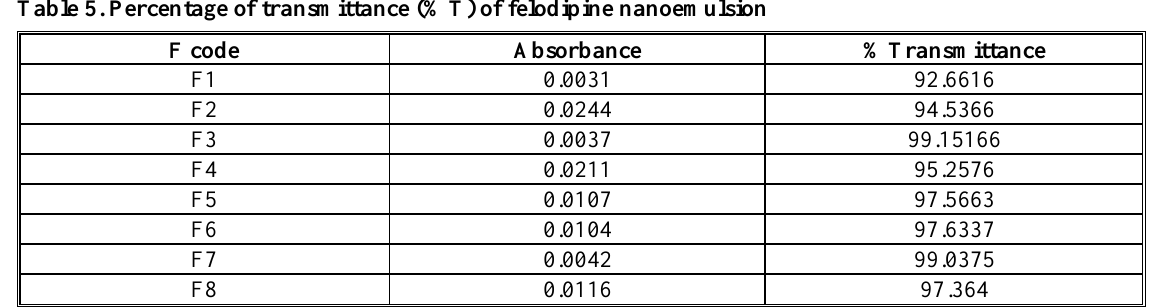
Table 5. Percentage of transmittance (%T) of felodipine